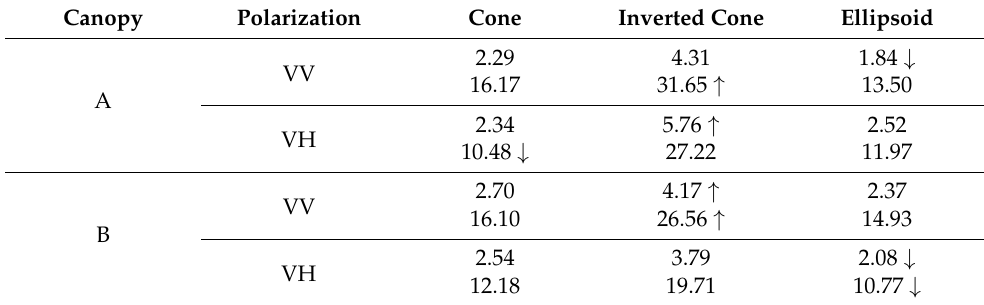
Figure 19. The averaged FEKO simulation results of the backscattering coefficients for different crown shapes at VV and VH polarizations of C band (5.3 GHz) when using canopy B’s parameters as inputs. ( a ) VV polarization; ( b ) VH polarization. Table 6. µ a and µ r of FEKO simulation results between the three crown shapes studied and the reference cylinder crown shape at VV and VH polarizations of C band (5.3